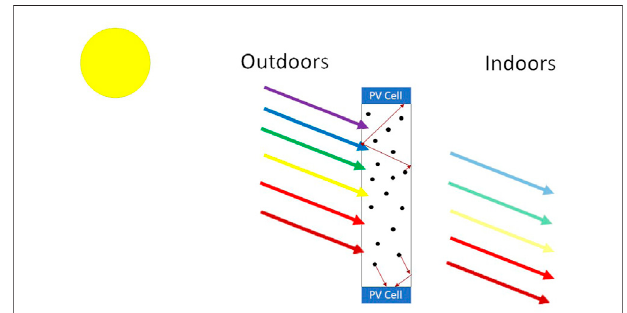
FIGURE 1 | Working principle of a luminescent solar concentrator. The incoming solar photons are partly absorbed by a luminophore (black dots), and subsequently emitted towards the sides (red arrows) where they can arrive, after total internal re fl ection from the edges of the waveguide material, at the side-mounted PV cells. Note that only part of the light is captured as shown by the fading of the colored arrows. Based on the picture from Mangu [11].